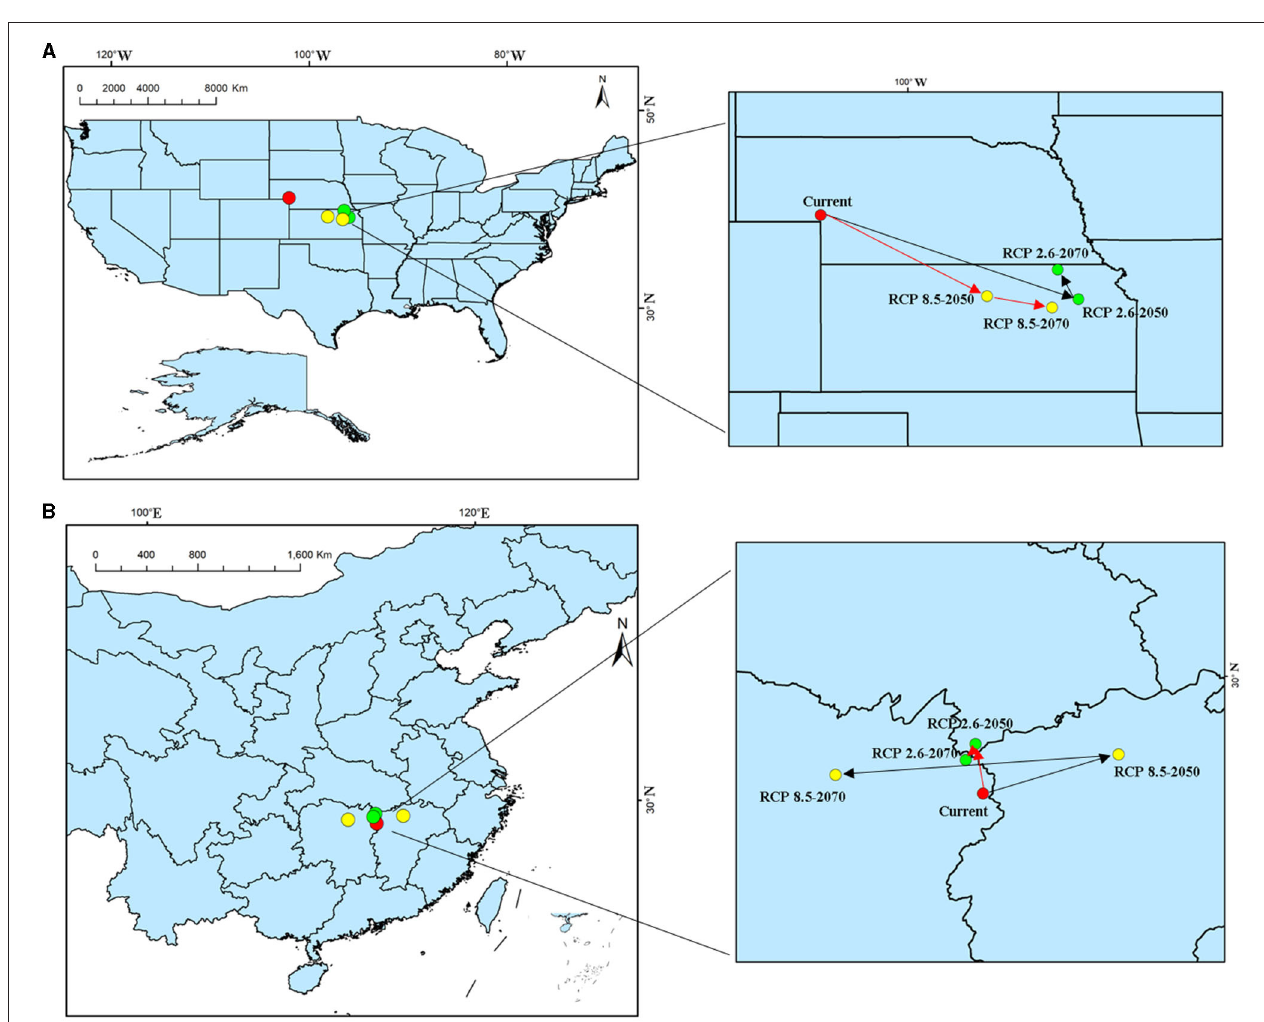
FIGURE 7 | Geometric central migration of S. alterniflora habitat suitability areas in 2050 and 2070 under two distinct climate change scenarios. (A) America; (B) China.